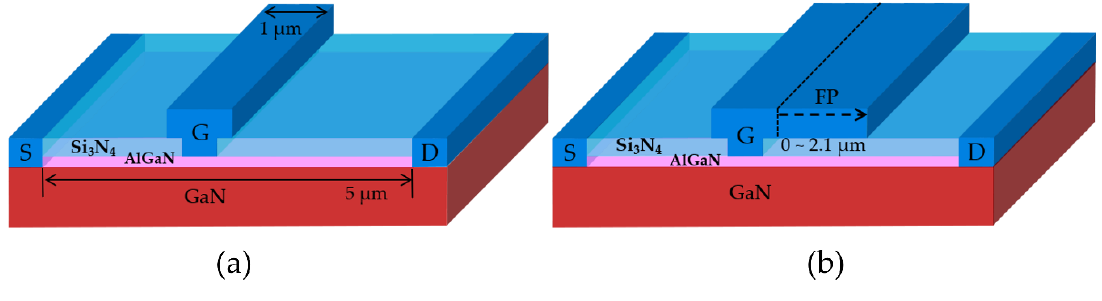
Figure 4. T-shaped AlGaN/GaN HEMT structure: ( a ) conventional T-shaped gate structure; ( b ) schematic of the drain-side field-plate (FP) structure.